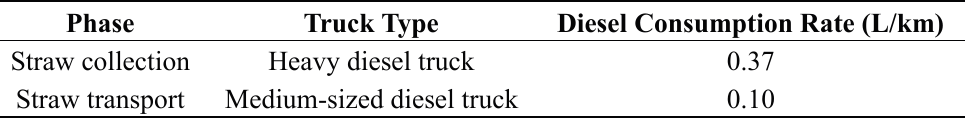
Table 6. Diesel consumption rates in different types of trucks.